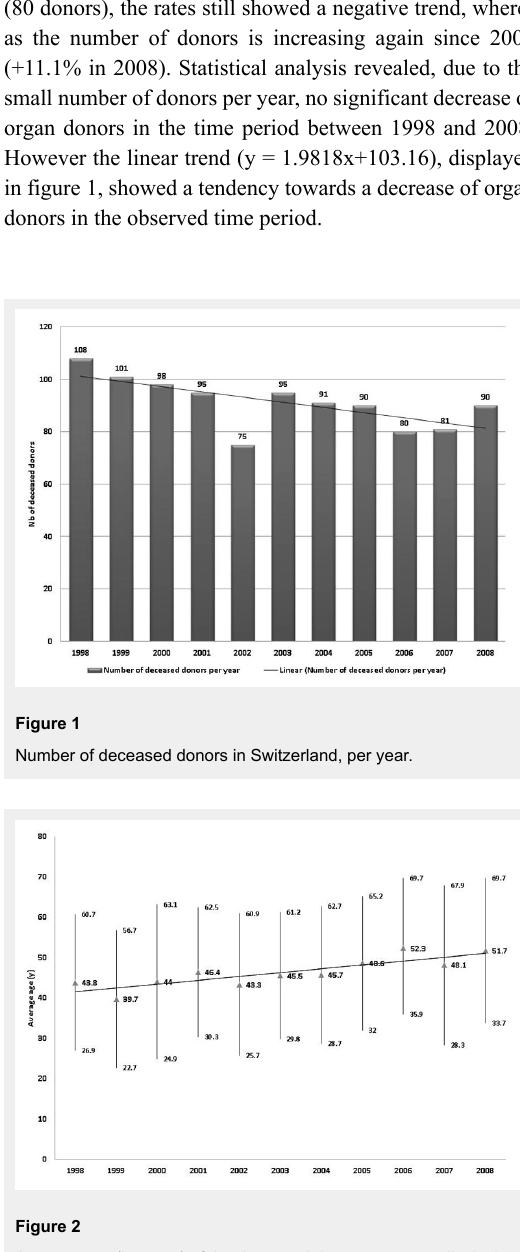
Average number of organs procured per donor, displaying ±1.SD (standard deviation) and linear